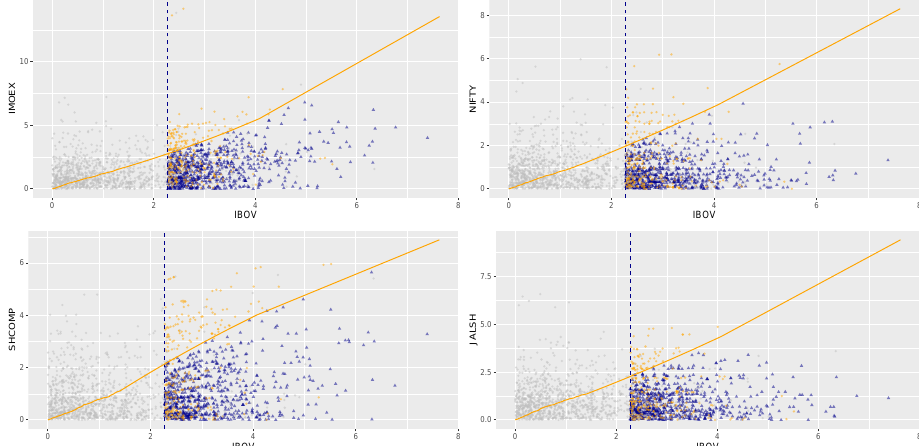
Figure 7. Prediction plot conditioning on IBOV being above its 90th